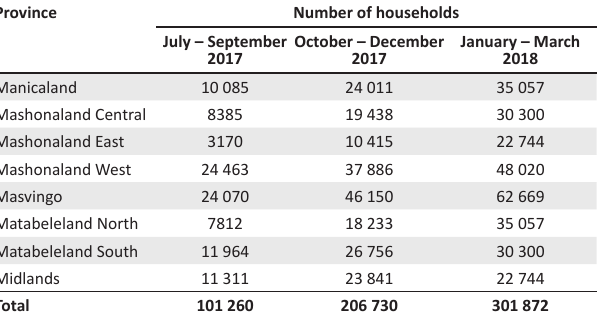
TABLE 1 : Food insecurity in Zimbabwe 2017.